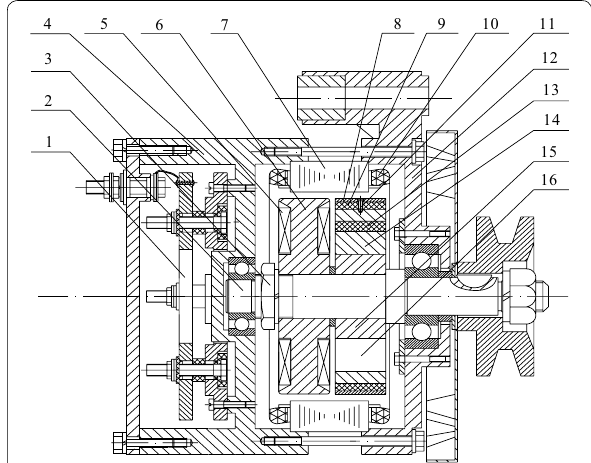
Figure 1 Structure diagram of double-radial permanent magnetic and salient-pole electromagnetic hybrid excitation generator.